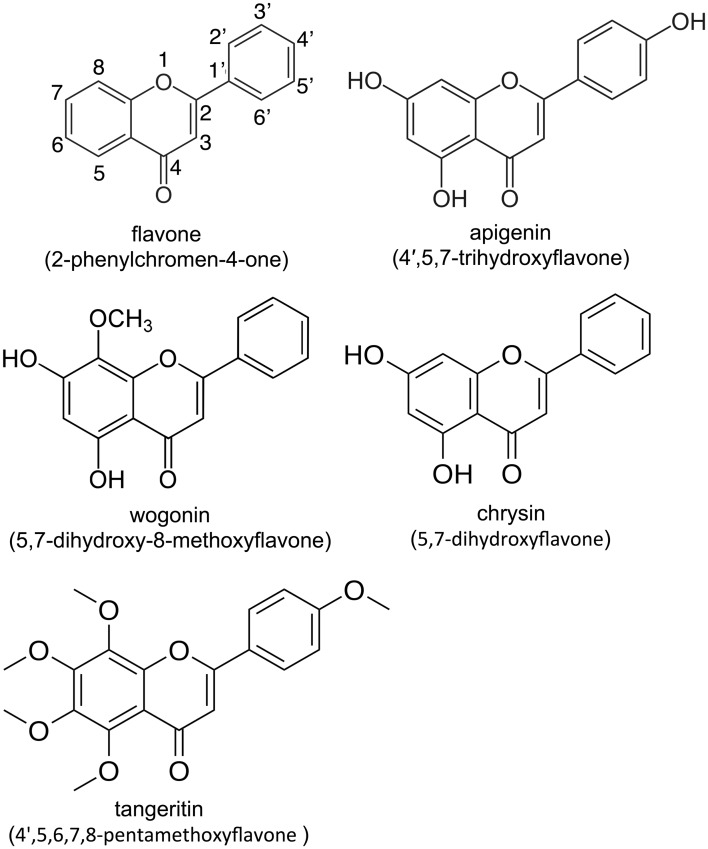
Flavone backbone structure and specific compounds used in this study.